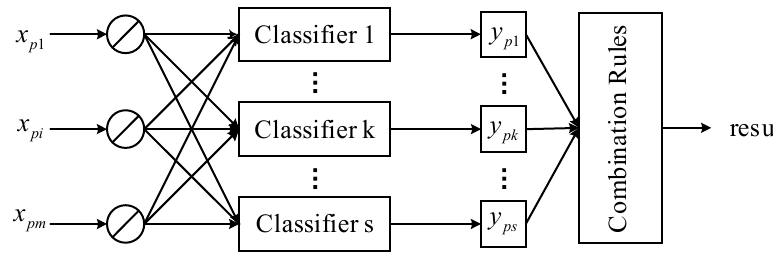
Figure 3. Structural schematic diagram of an ensemble classifier.